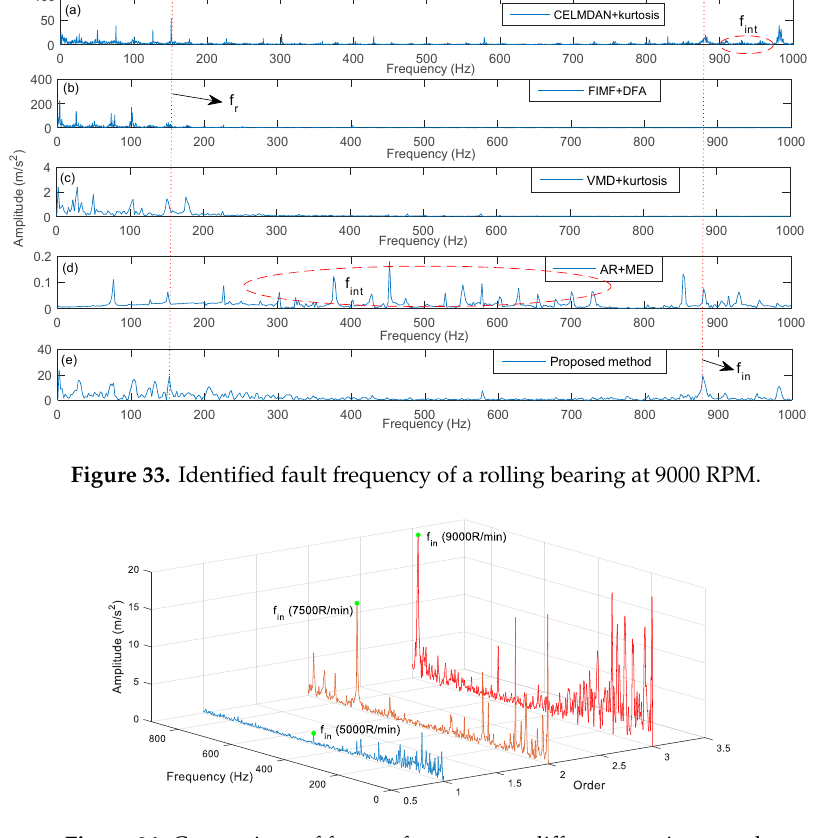
Figure 34. Comparison of feature frequency at different rotation speed.